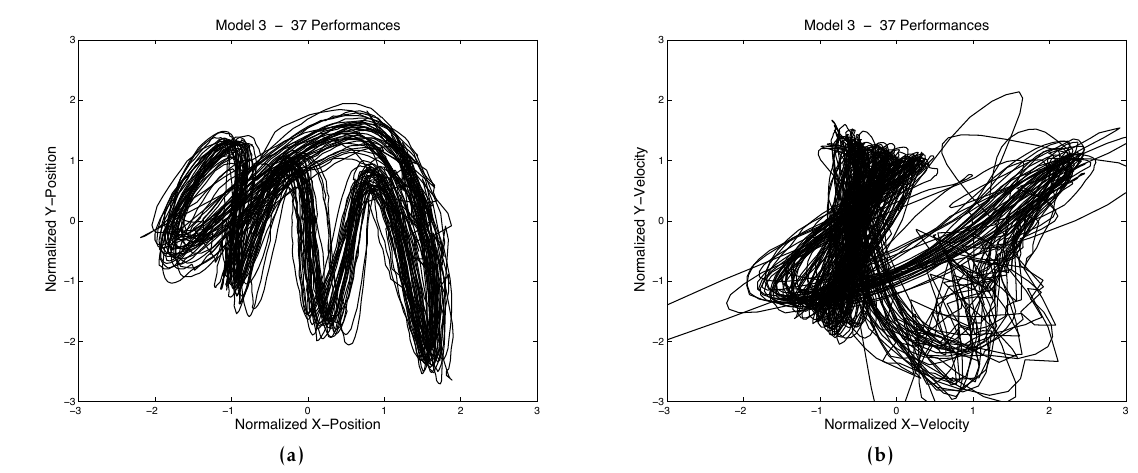
Figure 4. Normalized trajectories, with (a) being the positional coordinates, and (b) being the velocity coordinates. The trajectories for 37 basic gestures are shown.